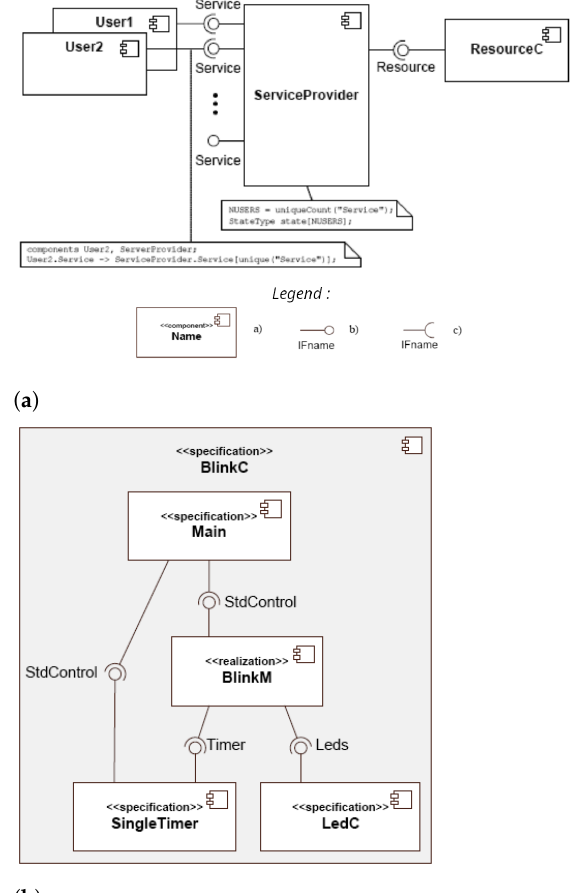
Figure 3. UML usage for modeling NesC-based software components. ( a ) Example: Pattern Service Instance in UML notation. ( b ) Component UML notation: using